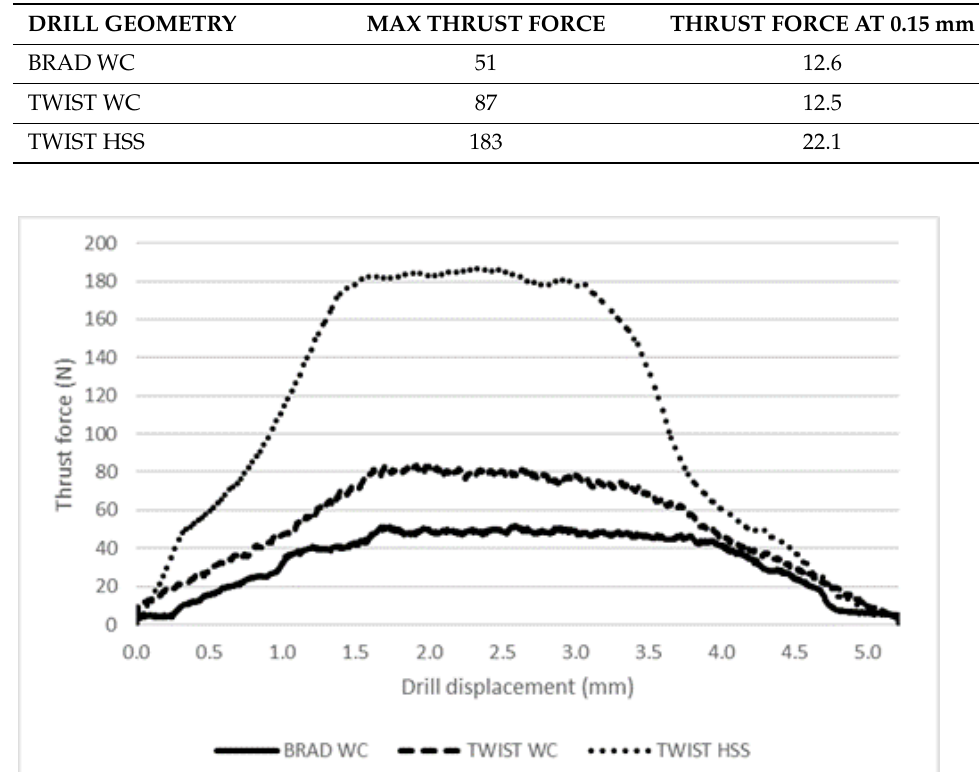
Figure 3. Comparison of thrust force during drilling of plates.